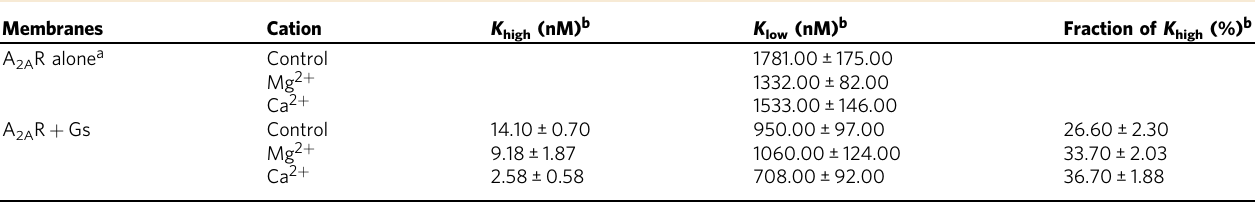
a Data for A 2A R alone were fi t to a single site b K high , K low and fraction of K high were fi tted using non-linear regression using Prism software (GraphPad, La Jolla,